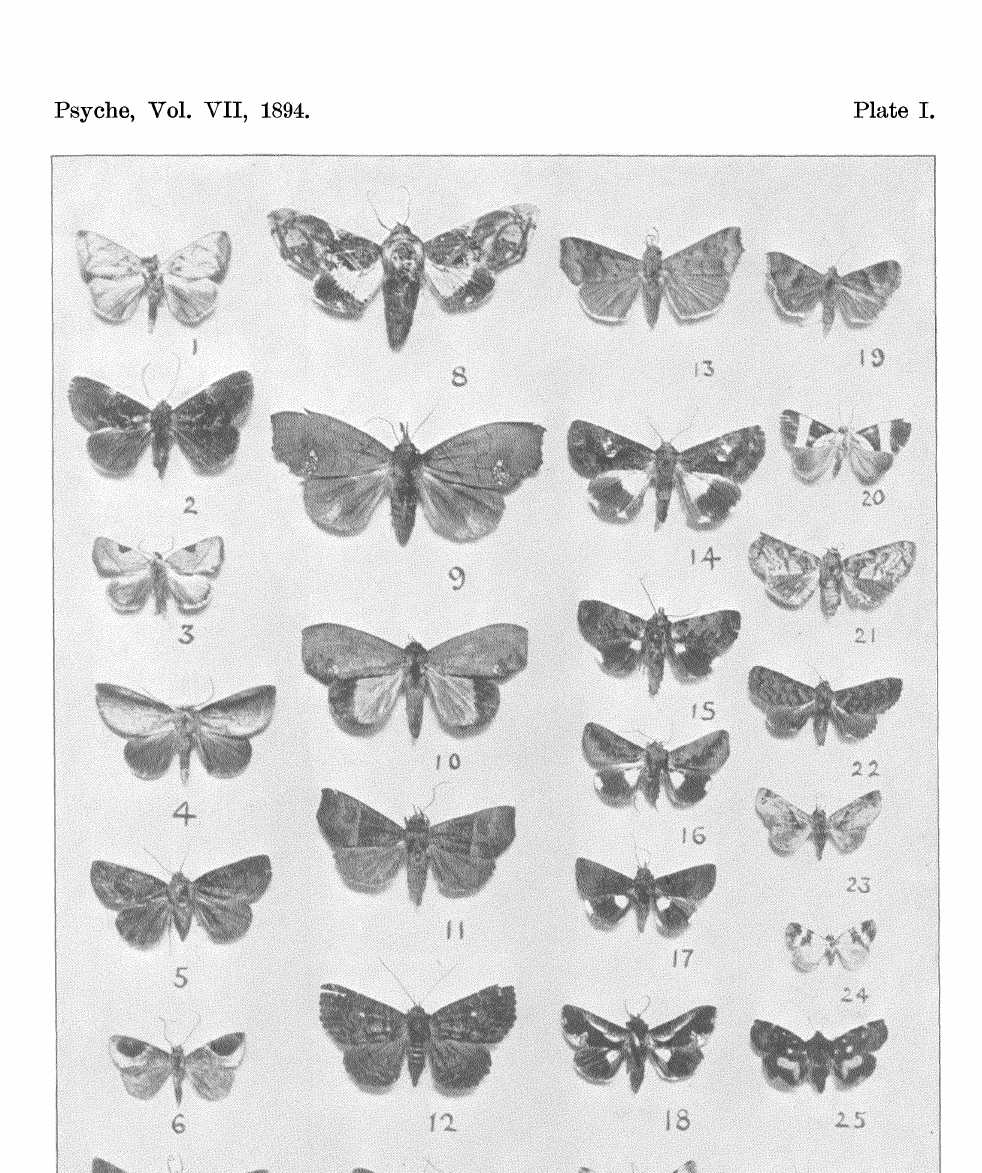
N OCTUA, (REDUCED